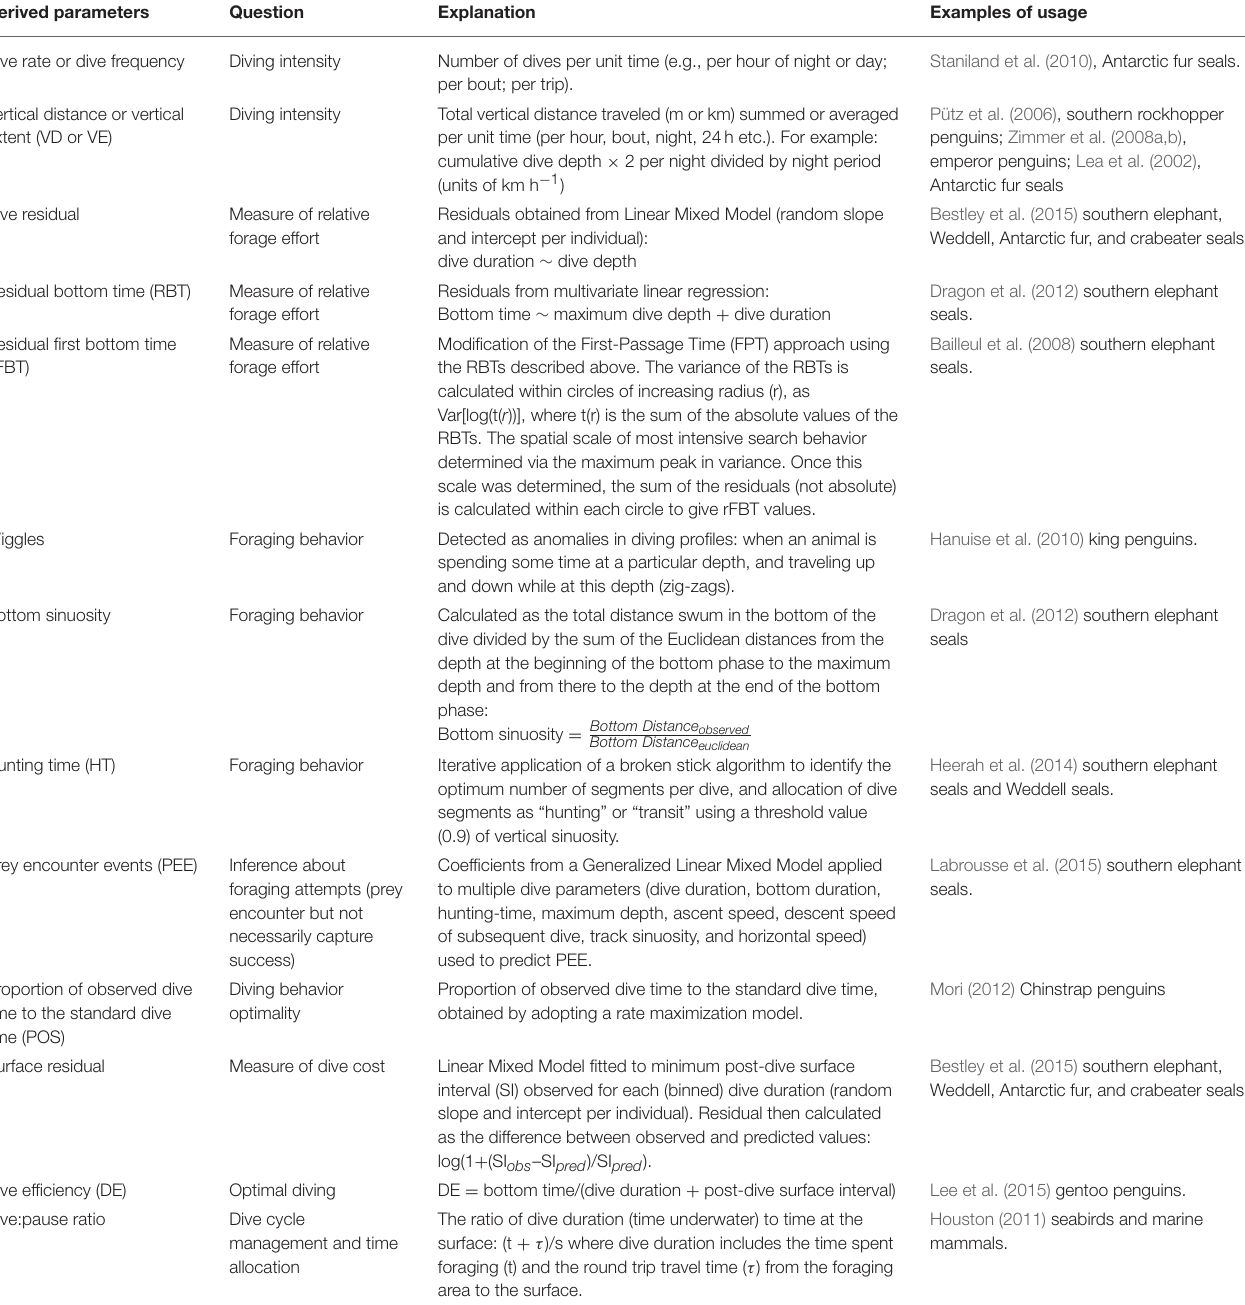
TABLE 3 | Examples of derived dive parameters to investigate diving patterns, foraging behavior, and physiology of SO marine predators. Derived